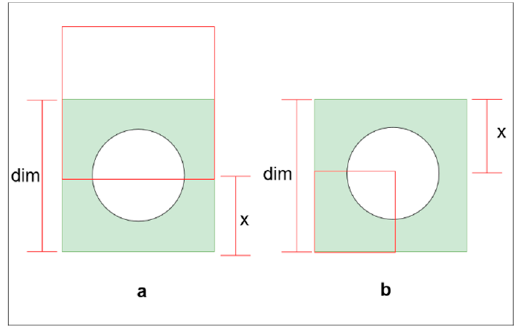
Figure 3. Overlap between ground truth and predicted bunding box ( a ) with overlap outside the optic nerve head (ONH) and ( b ) with overlap inside the ONH